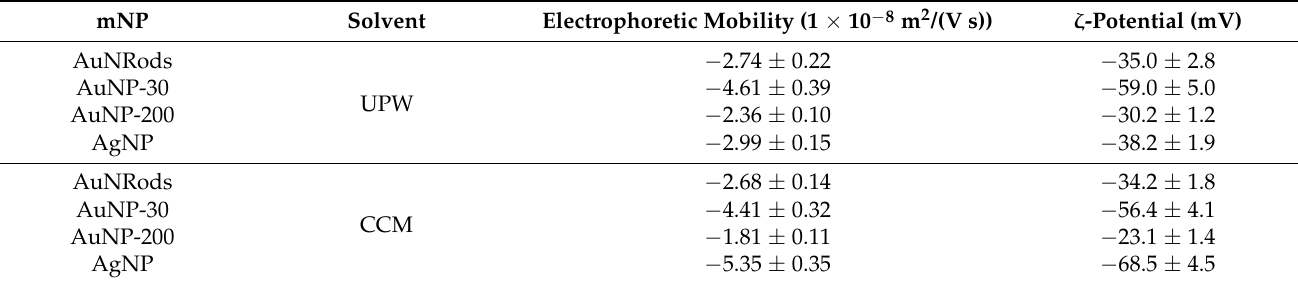
Table 2. ζ -potential results obtained from EAF4-UV–VIS analysis for different metallic nanoparticles (mNP). The elec- trophoretic mobility values for all investigated mNP and their respective ζ -potential values. The displayed uncertainties were obtained from the linear least squares analyses. UPW = ultrapure water, CCM = cell culture